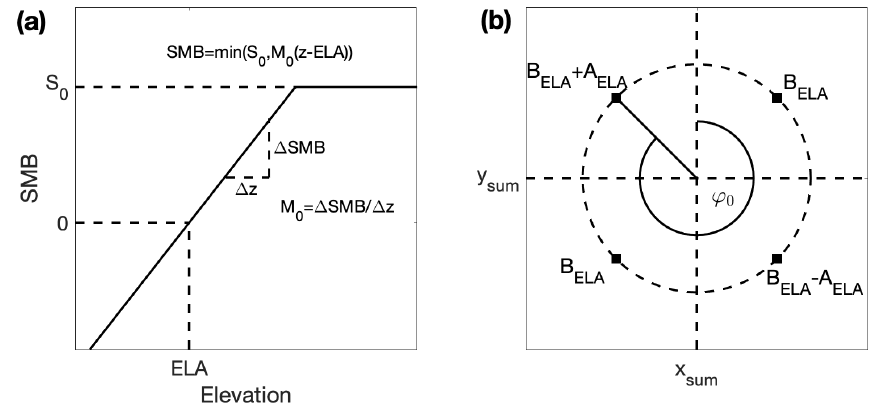
Figure 3. (a) Elevation-dependent SMB parameterization. SMB increases linearly with elevation until an upper bound S 0 and stays constant at higher elevations. (b) Aspect-dependent SMB parameterization. Equilibrium line altitude (ELA) takes a minimum and maximum on two opposite directions ( B ELA ± A ELA ) and their mean ( B ELA ) on perpendicular directions. ϕ 0 is a direction offset to rotate the values according to the atmospheric conditions. In this visualization, ϕ 0 is set to 315 ◦ , the value used in this study, and ( x sum ,y sum ) indicates the position of Mocho’s